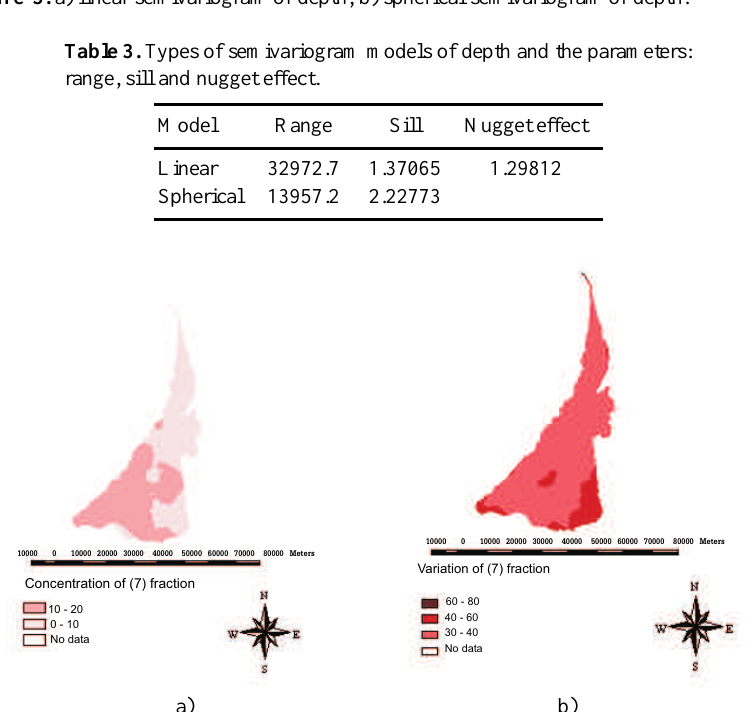
Figure 4. Kriging method: a) prediction map of fraction (7); b) variation map of fraction (7). map, (b) variation map). Maps obtained using cokriging method are shown in